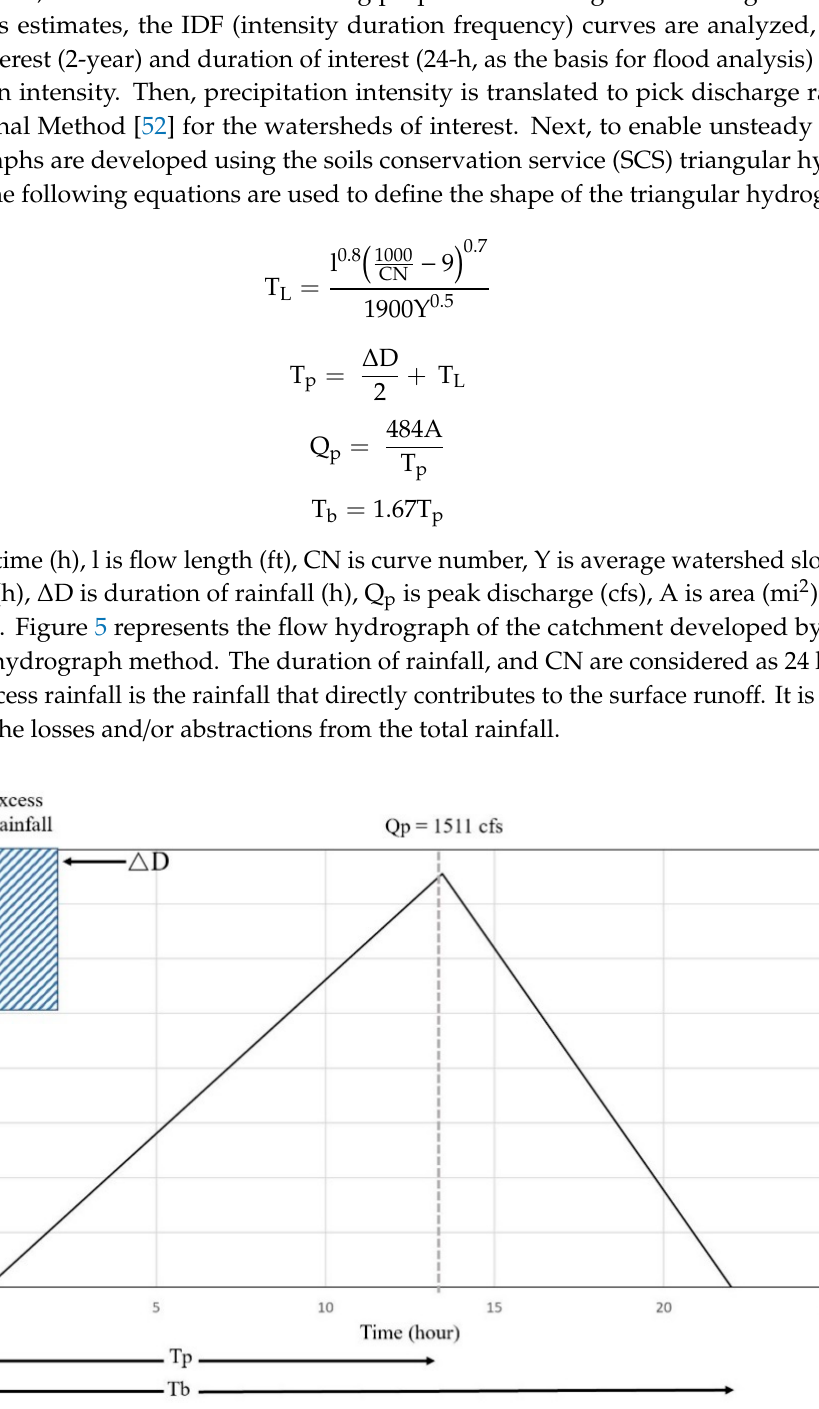
Figure 5. 2-year precipitation hydrograph for San Leandro Watershed using soils conservation service (SCS) triangle method.